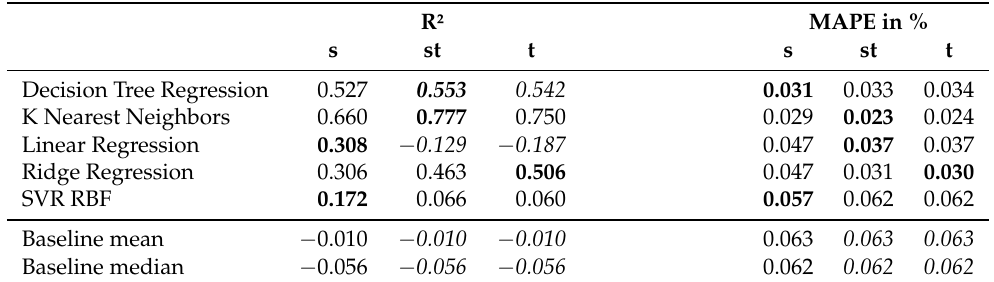
Table 4. Data Set Housing Part I: results for Target Weight. The differences in comparisons of st or t vs. s were tested for significance, using the Wilcoxon signed-rank test ( α = 0.05). Where the test did not confirm significant differences, the respective st or t values are printed in italic. The highest R 2 and the lowest MAPE are shown in bold for each algorithm.